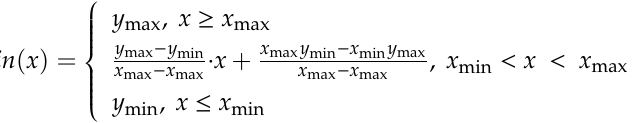
R →∞ . Calculation parameters: Table 1 and I 0 = 0.15 mA for